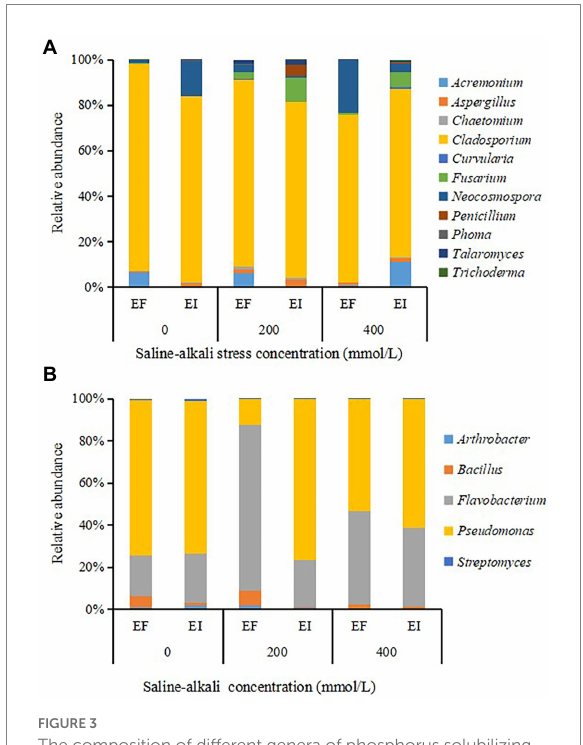
FIGURE 3 The composition of different genera of phosphorus solubilizing fungi (PSF) (A) and phosphorus solubilizing bacteria (PSB) (B) in roots of tall fescue with (EI) and without (EF) Epichloë endophyte under saline-alkali stress.